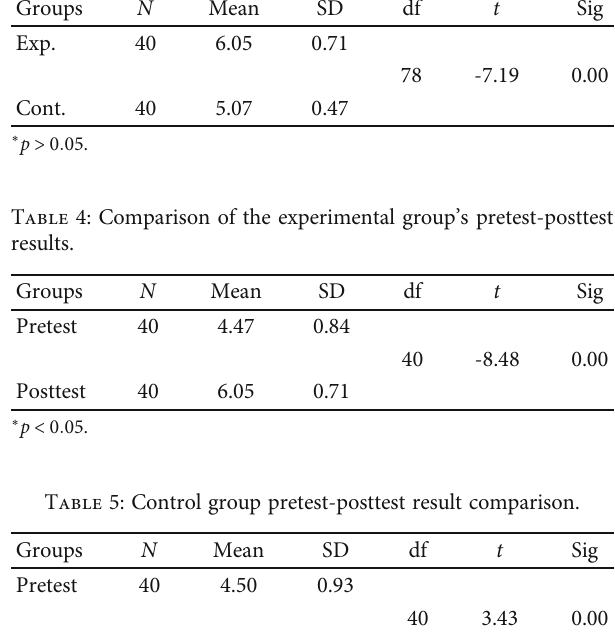
Table 3: Experimental and control group posttest result. Groups